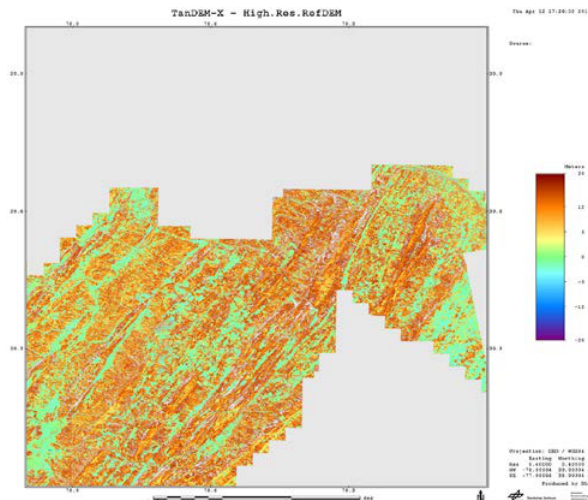
Figure 7: Difference between DEM tile N39W79 and USGS Seamless reference DEM (range of values [-20; Figure 6: Overview test site Virginia. Color shaded DEM of tile N39W79 superimposed on amplitude mosaick, RawDEMs marked red